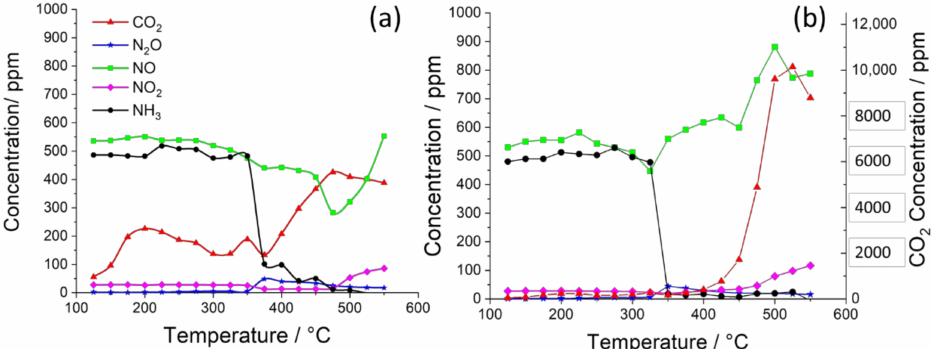
Figure 7. Performance of 2%Ag–10%K/CZA tested in a simulated exhaust gas containing NH 3 as reductant ( a ) in the absence of carbon black, and ( b ) in the presence of carbon